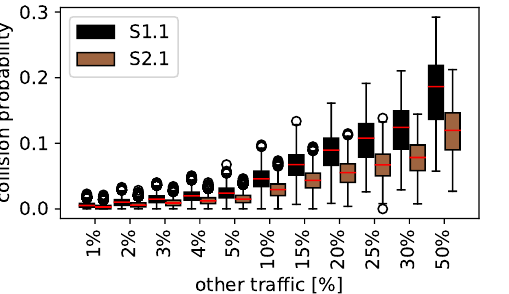
Figure 9. Comparison of Scheduled with random access (S1.1) and listen before talk